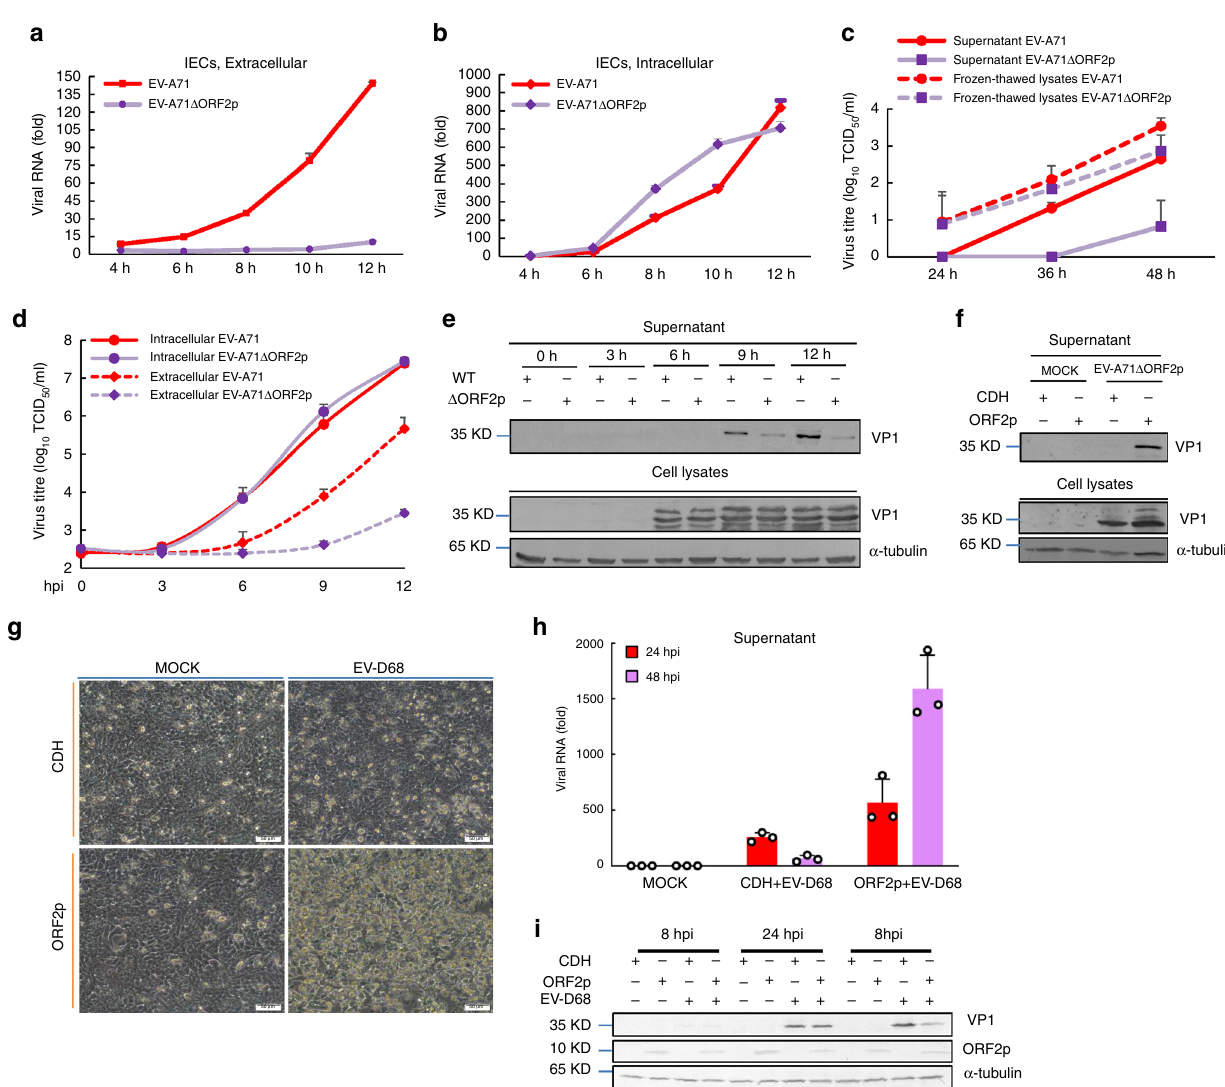
Fig. 4 ORF2p facilitates the release of enterovirus particles from isolated IECs and HT-29 cells. a – c Isolated primary IECs were transfected with 1 µ g in vitro - synthesized RNA transcripts of EV-A71 or EV-A71 Δ ORF2p ( n = 3 biologically independent experiments). Error bars denote SEM. Viral RNA in the culture supernatant a and cell lysates b was detected by an RT-PCR assay at the indicated times. c Virus titres of the supernatant or frozen-thawed lysates were determined at 24, 36, 48 h post-transfection. d , e Isolated primary IECs were challenged with EV-A71 or EV-A71 Δ ORF2p at an MOI of 10. d Virus titres of EV-A71 or EV-A71 Δ ORF2p in the supernatant or cell lysates were determined at the indicated times ( n = 3 biologically independent experiments). Error bars denote SEM. e The supernatant and cells were harvested at indicated time, followed by immunoblot analysis, as described above. f HT-29 cells stably expressing EV-A71 ORF2p or control HT-29-CDH cells were challenged with EV-A71 Δ ORF2p at an MOI of 0.1. The supernatants and cells were harvested for immunoblotting using antibodies against EV-A71 VP1 and α -tubulin. CDH, control HT-29-CDH cells. g Detection of the EV-D68-induced cytopathic effect (CPE). HT-29-ORF2p or control HT-29-CDH cells were infected with equal amounts of EV-D68, and CPE was imaged via light microscopy. Scale bars equal 50 μ m. h , i HT-29-ORF2p or control HT-29-CDH cells were infected with equal amounts of EV-D68. h The supernatant was harvested at 24 and 48 hpi for RT-PCR assays ( n = 3 biologically independent experiments). Error bars denote SEM. i Cells were harvested at 8, 24, and 48 hpi, followed by immunoblot analysis. Source data are provided as a Source Data fi